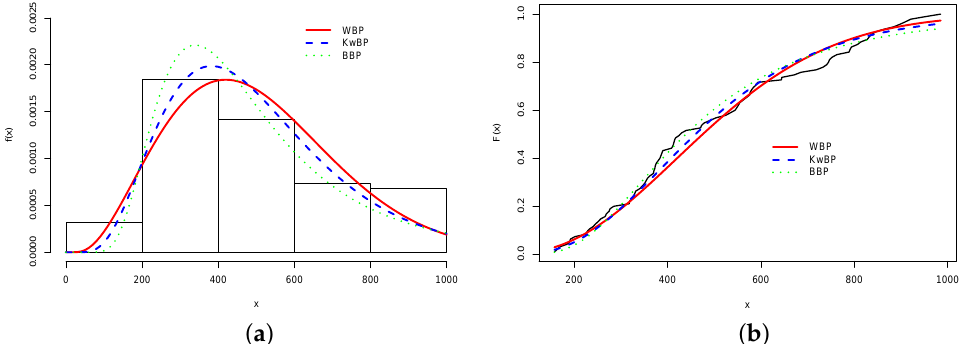
Figure 5. ( a ) Best estimated densities for COVID-19 data in US; ( b ) empirical and estimated cumula- tive distributions.